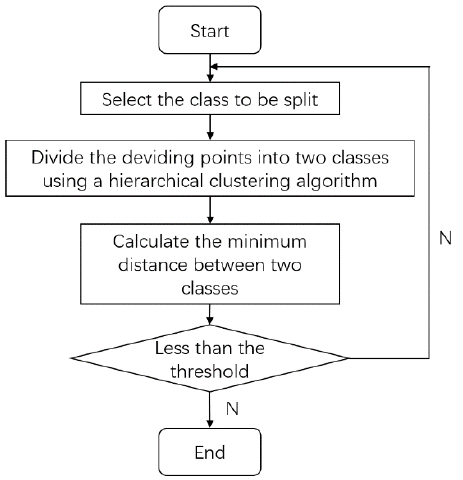
Figure 10. Outlier extraction process.